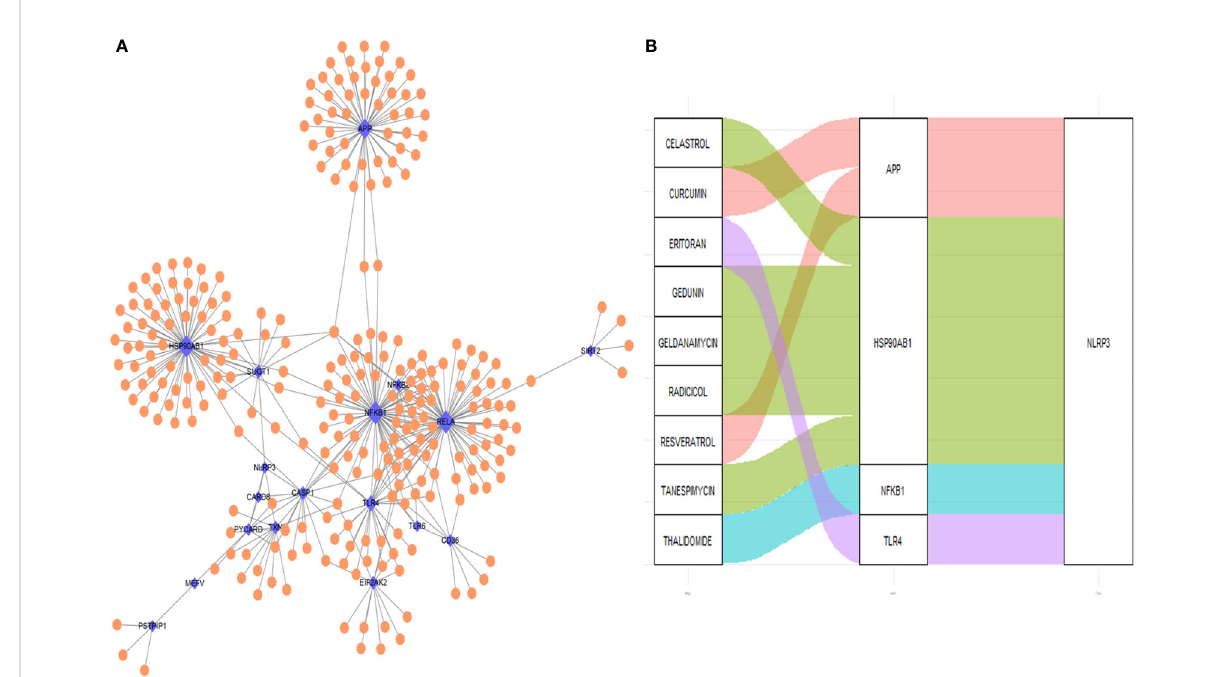
FIGURE 11 Drug-gene interaction network and potential drug prediction. (A) Network of protein-protein interaction. (B) Drug-interaction prediction of key genes. Four key genes (APP, HSP90AB1, NFKB1 and TLR4) were targeted in the DGIdb database. Nine potential target drugs were predicted from the database. Blue: NLRP3 in fl ammasome-related genes, orange: non-NLRP3 in fl ammasome-related genes. the size of the point indicate the drugs interacts with NLRP3 in fl ammasome-related